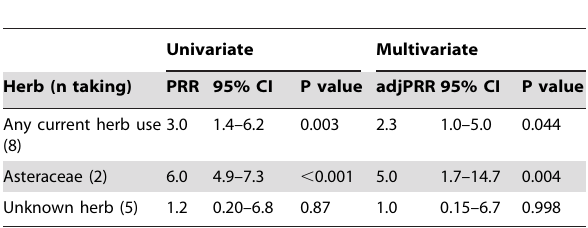
Table 6. Association of herbs with significant liver fibrosis in HIV-infected participants.